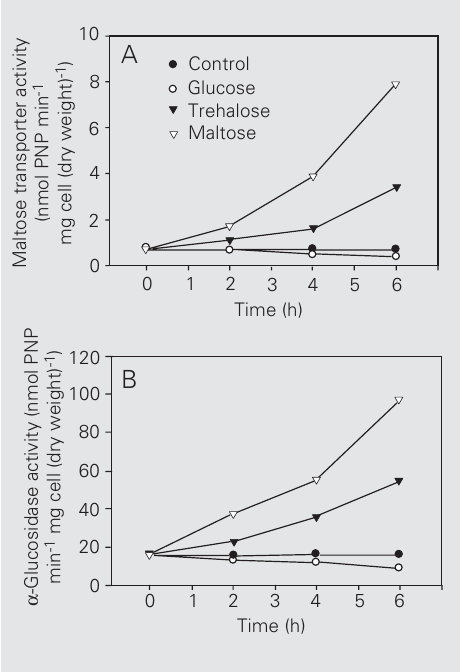
3. Induction and catabo- lite repression of α -glucosidase and maltose transporter activi- ties in Candida utilis. Cells (50 mg dry weight) from a liquid cul- ture in YNB medium containing 1% glucose at 3.3 mg of cells (dry weight)/ml were reinocu- lated into 100 ml of fresh YNB media containing 1% glucose, 1% trehalose or 1% maltose. Maltose transporter (panel A) and α -glucosidase (panel B) ac- tivities were determined in cell samples collected at the times indicated. PNP, p